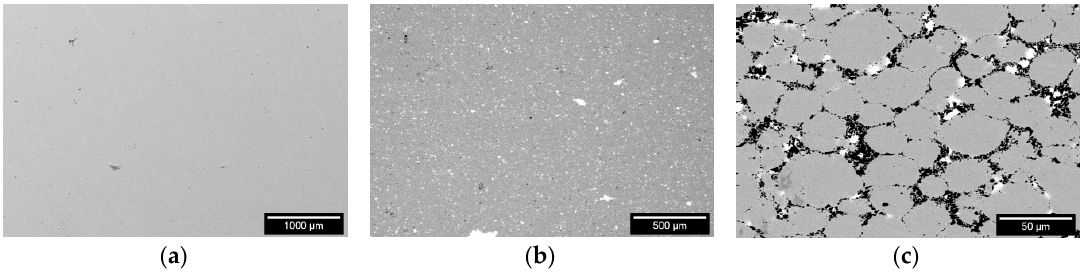
Figure 2. SEM images of the polished sintered samples: ( a ) 100NiCr, ( b ) NiCr-Re, and ( c ) NiCr-1Re-Al 2 O 3 .